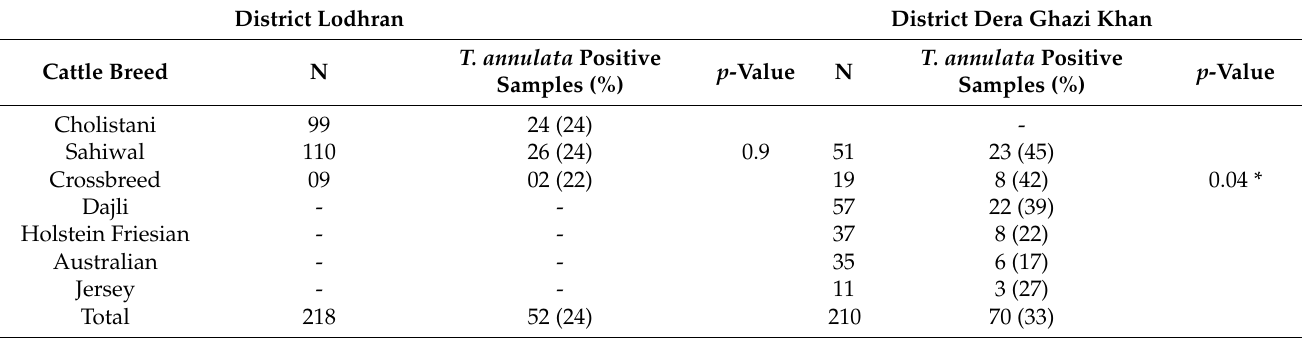
Table 2. Comparison of Theileria annulata prevalence in blood samples according to cattle breeds collected during the present study from Lodhran and Dera Ghazi Khan Districts. N represents the total number of cattle samples collected from each breed. The % prevalence of T. annulata is given in parenthesis. p -value indicates the results of one-way ANOVA estimated for the studied